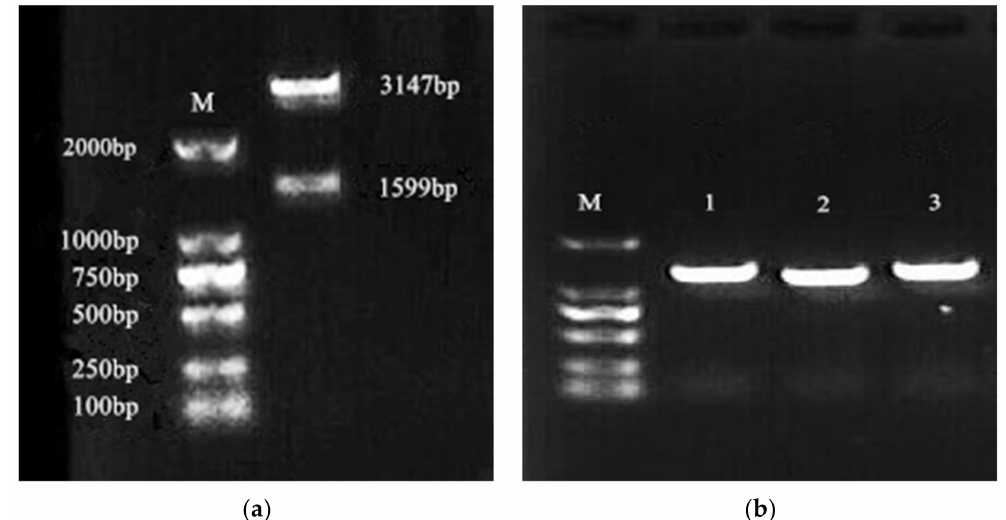
Figure 2. Double enzyme digestion identification and PCR verification of positive strains. ( a ) Double enzyme digestion identification results, lane ‘M’ is the DNA Marker; ( b ) detection results of PCR, lane ‘M’ is the DNA marker, lane 1–3 are the PCR product of X33-Lac-2.